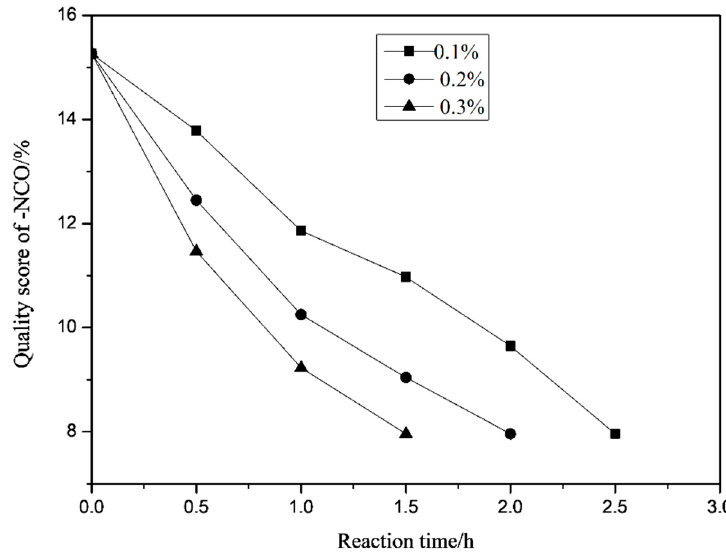
Figure 12. Effect of catalyst dosage on -NCO conversion rate.